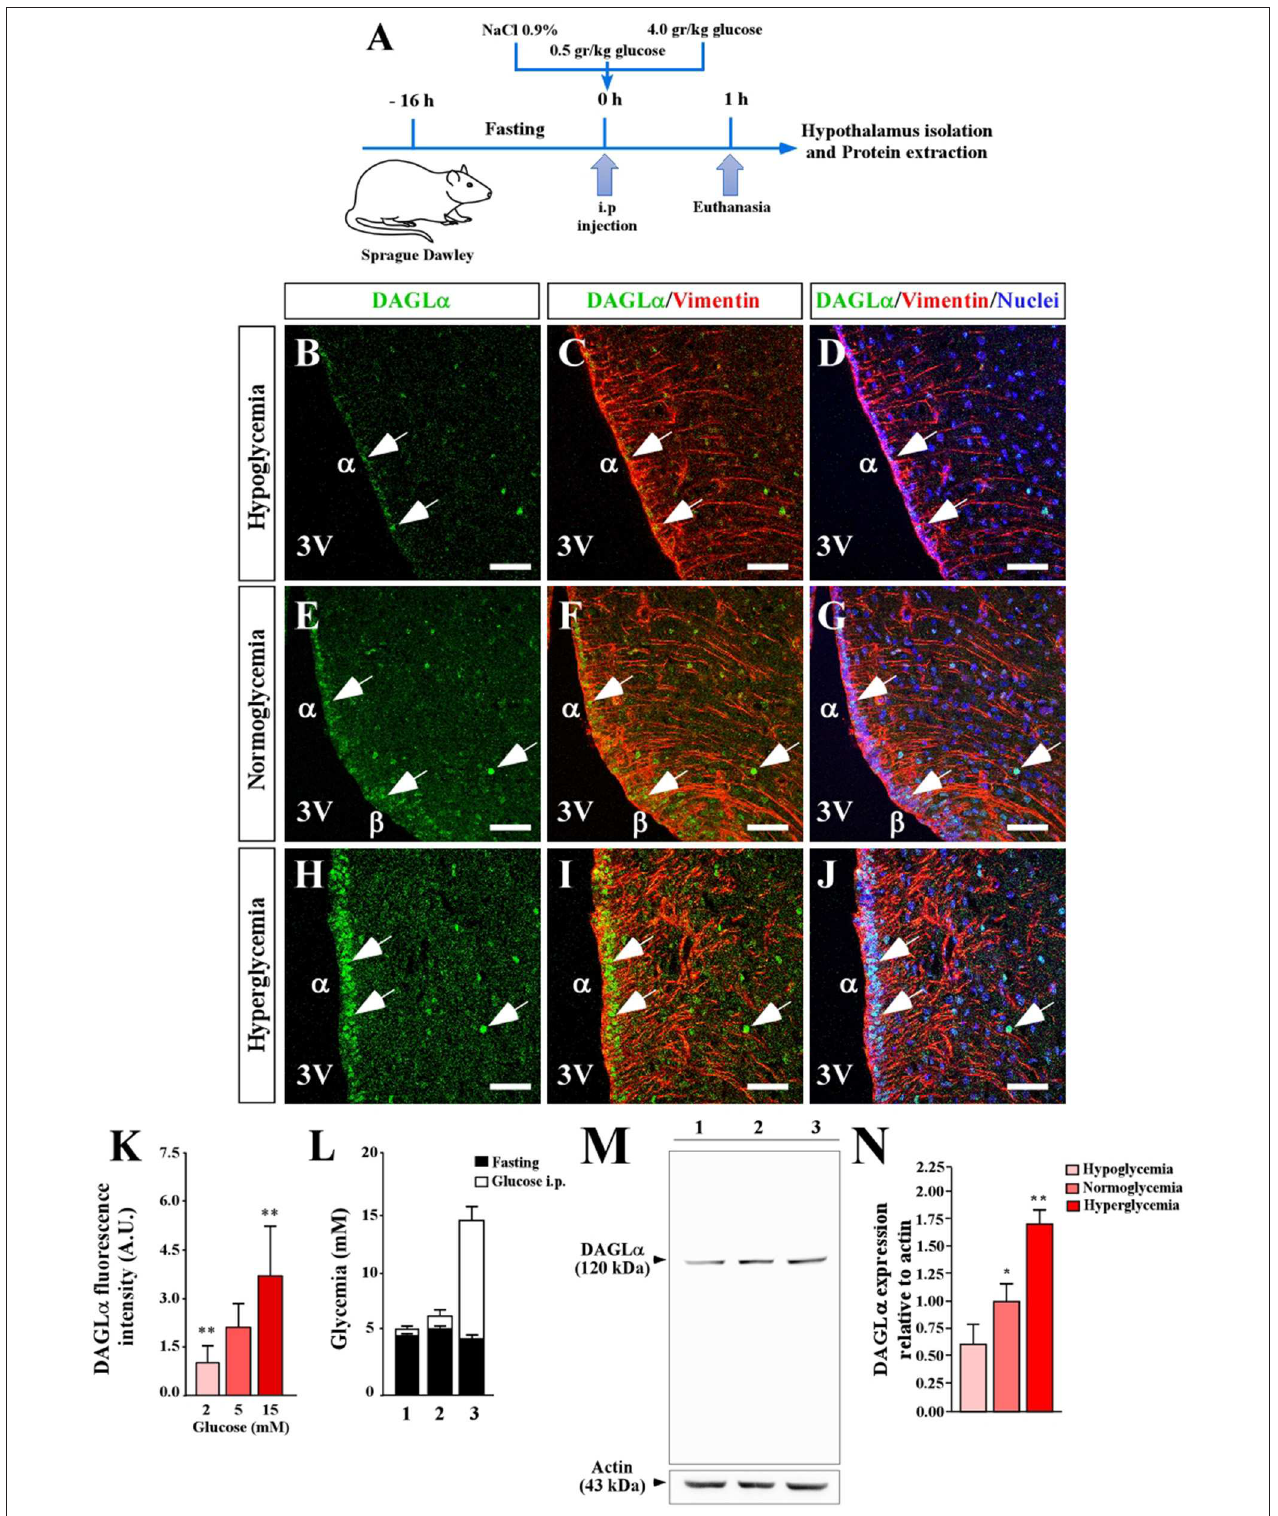
FIGURE 2 | Effect of extracellular glucose on the expression of DAGL α in the basal hypothalamus. (A) Scheme of the experimental protocol. (B–J) Confocal microscopy of a coronal section (40 µ m) of rat hypothalamus stained with anti-DAGL α (green), anti-vimentin (red) and TOPRO-3 as a nuclear marker.